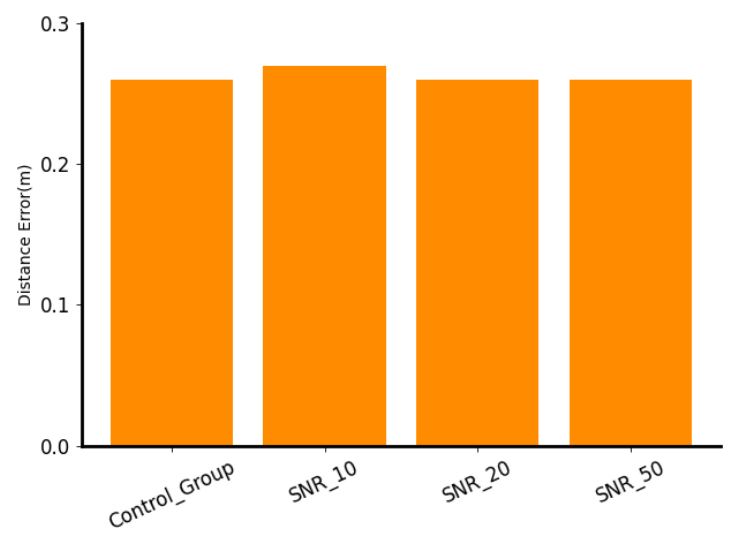
Figure 10. The MeanError after 300 training